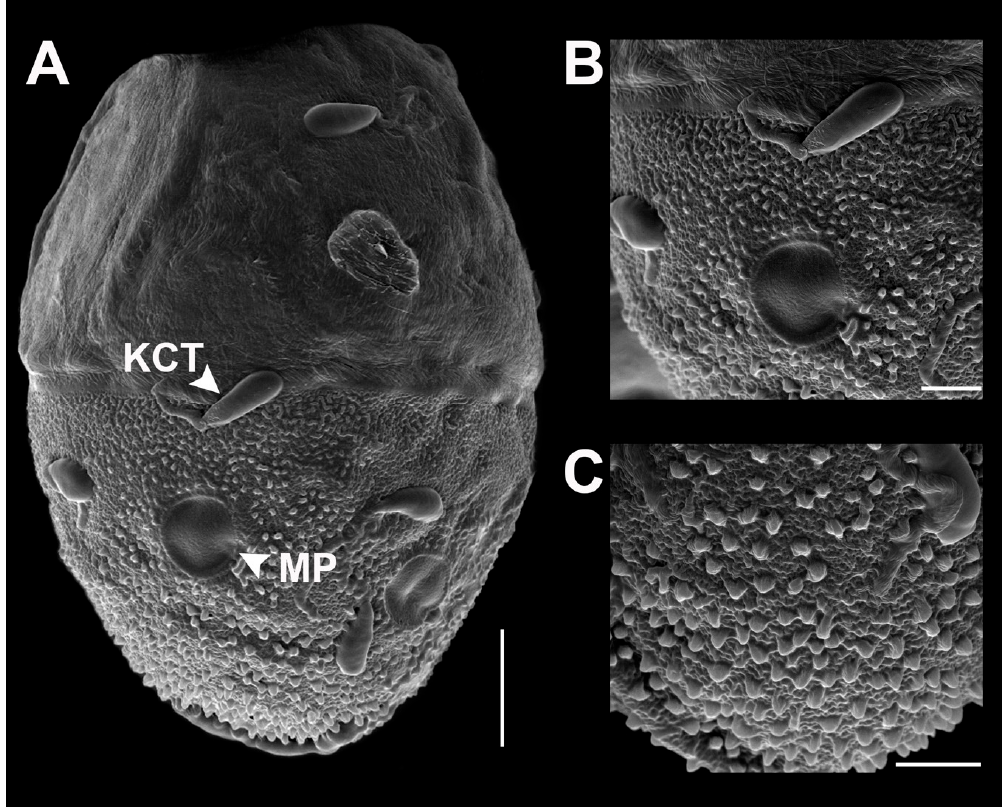
Figure 6. SEM of egg structure of Vietnamella nanensis sp. n. ( A ) overview of egg structure; (B ) detail of Knob terminated Coiled Thread (KCT) and micropyle; ( C ) chorionic surface of posterior area. Scale bars 50 µm ( A ); 20 µm ( B ); 10 µm ( C ). Female subimago (Figure 7B). Body length 12–14 mm without cerci. Head. Eyes yellowish.